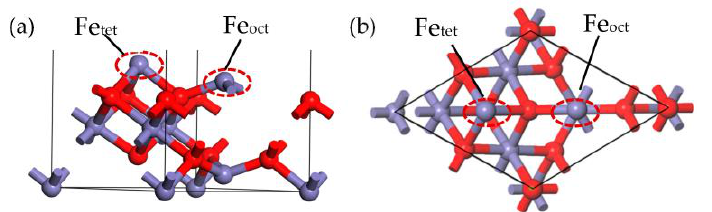
Figure 13. The side view of γ -Fe 2 O 3 (111) ( a ) and the top view of γ -Fe 2 O 3 (111) surface ( b ) (N, blue; Fe, purple; O, red).